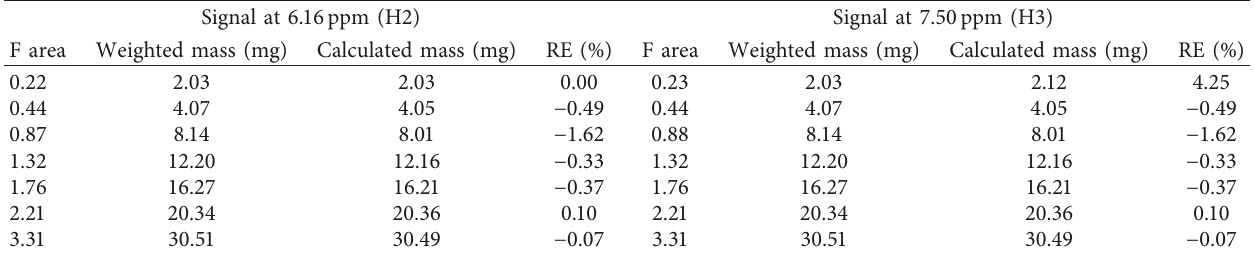
Table 2: Accuracy of 5-hydroxymethyl-2(5H)-furanone (F) measurements by 1 H NMR. Signal at 6.16ppm (H2)